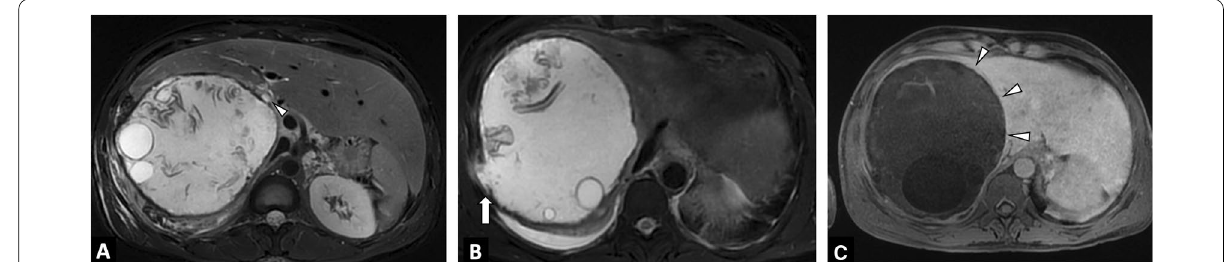
Fig. 19 Cystic echinococcosis lesion CE3b in a 48‑year‑old patient revealed by abdominal pain, fever, and liver blood test abnormalities. A Fat‑suppressed T2‑weighted MR image in the axial plane shows a cystic lesion of the right liver, including daughter cysts with floating membranes. Biliary compression without fistula can be observed (arrow). B Fat‑suppressed T2‑weighted MR image in the axial plane. Posterior rupture of the cystic echinococcosis (arrow). C Fat‑suppressed T1‑weighted sequence in the axial plane shown after gadolinium injection at the portal phase. Parietal enhancement of cystic echinococcosis that suggests infection of parasitic lesion